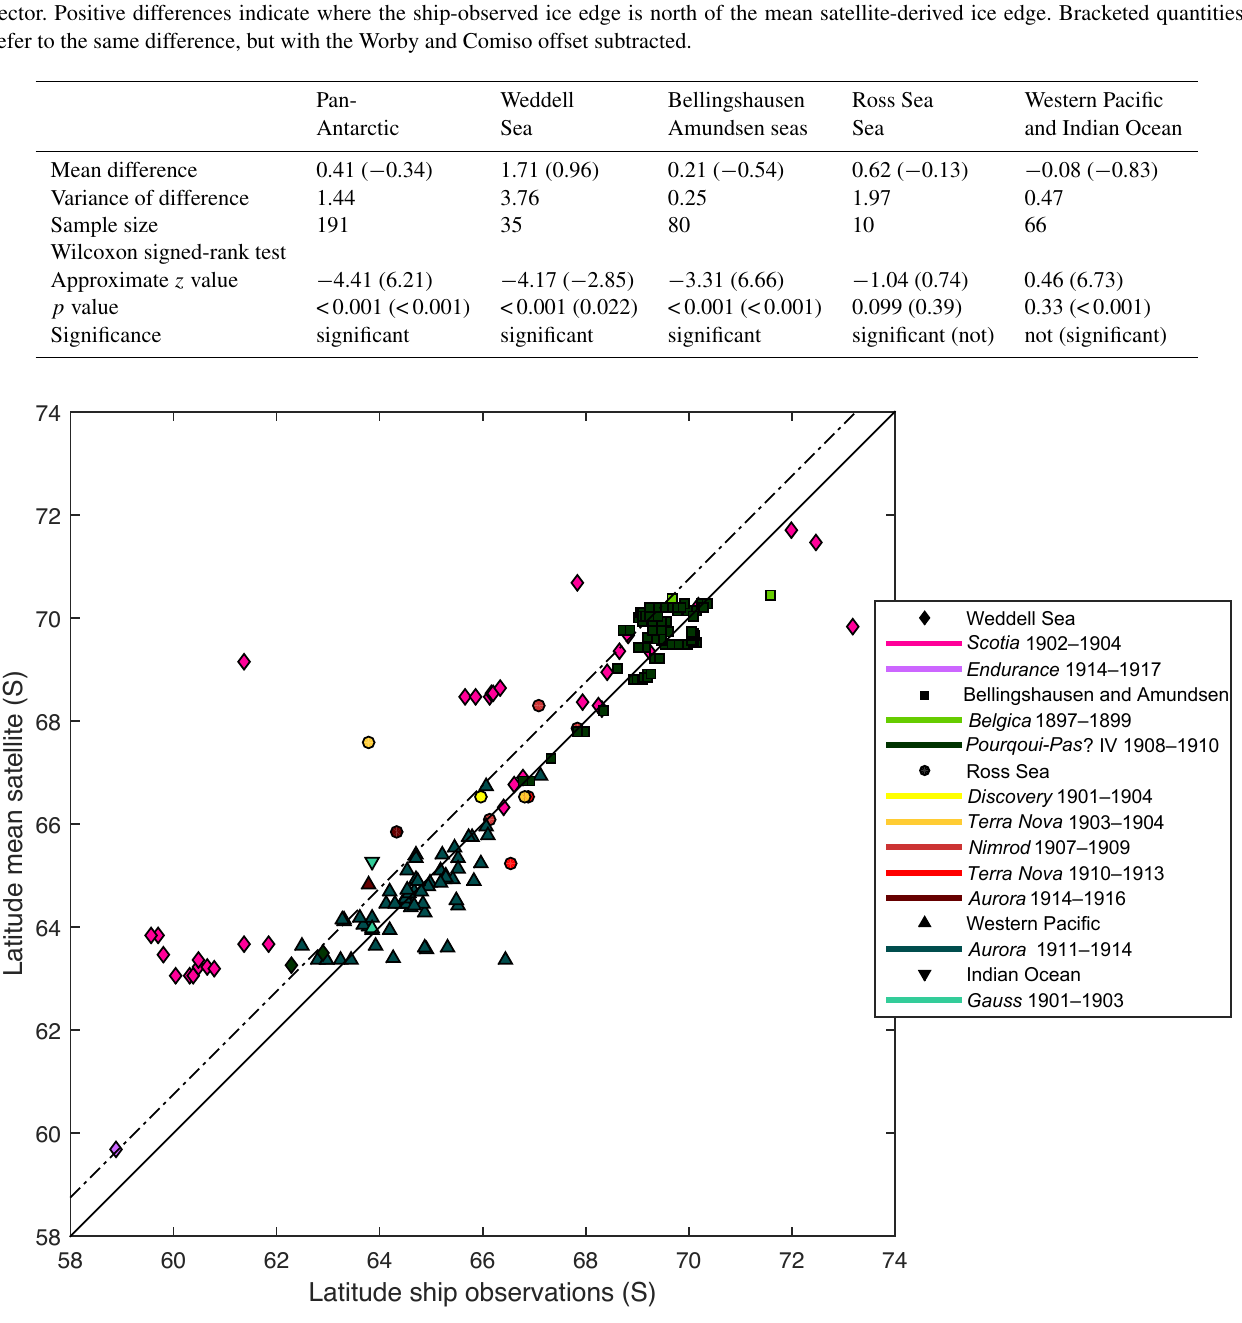
Figure 3. Comparison of ship-observed and satellite-derived ice edge latitude, including a one-to-one line, which indicates no change in position. The dashed line provides an estimate of the southward offset one would expect when comparing the satellite-derived ice edge to in situ ship observations, as calculated by Worby and Comiso